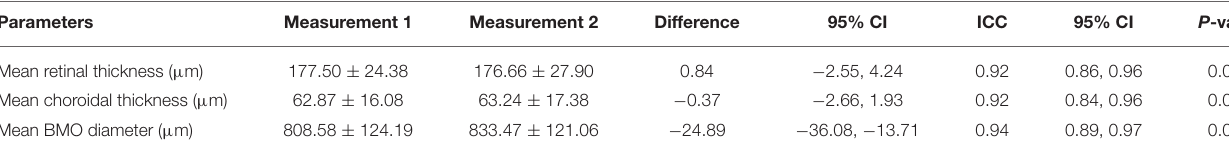
TABLE 2 | Intra-observer analysis showing the repeatability of measurements performed by the same observer in two different occasions. Parameters